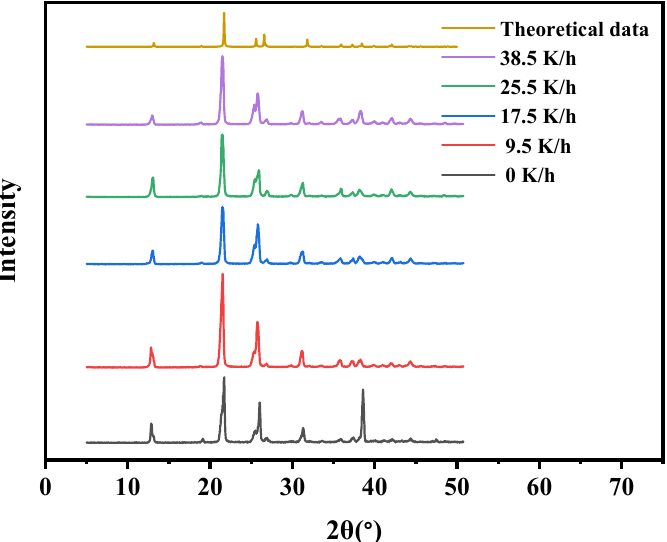
Figure 3. PXRD pattern of adipic acid.